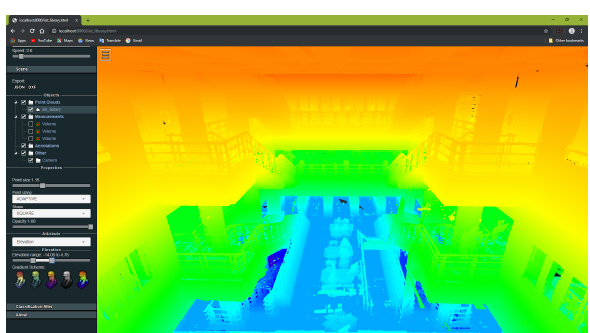
Figure 7. Interior of the library visualised in linear colour map representing height from ground.